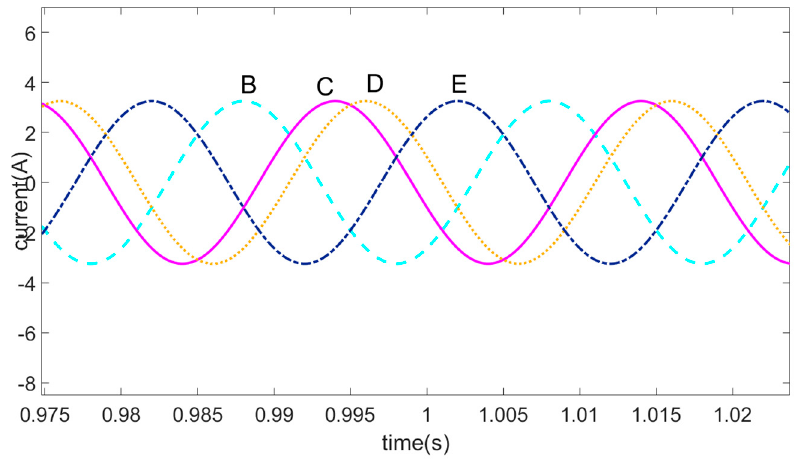
Figure 5. Schematic diagram of remaining four − phase currents after fault − tolerant control in case of open − circuit fault of phase